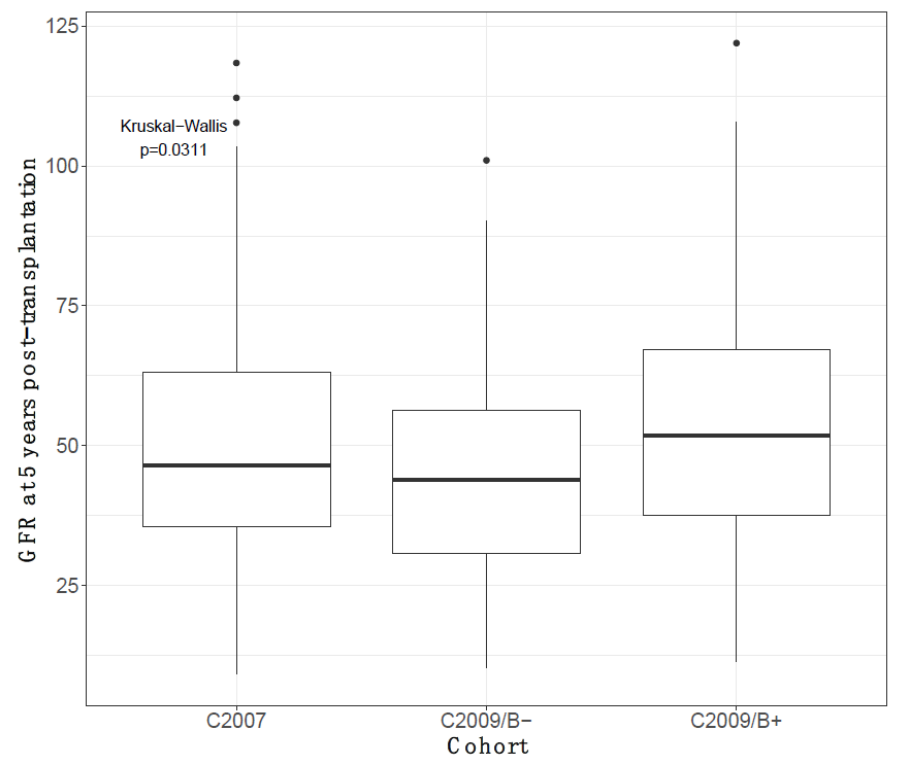
Figure 4. Five-year eGFR comparisons between the three different cohorts (CKD-EPI, mL/min/1.73 m 2 ).